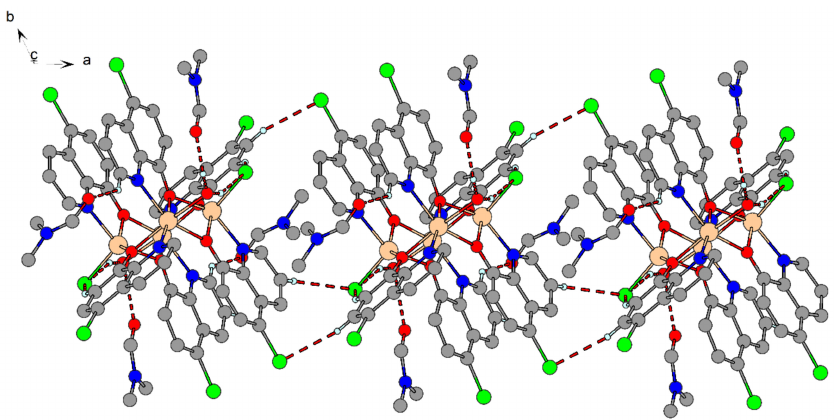
Figure 7. Part of the one-dimensional structure of 2 viewed along the c axis with hydrogen bonds (red dashed lines). Only hydrogen atoms involved in the hydrogen bonds are shown for clarity.